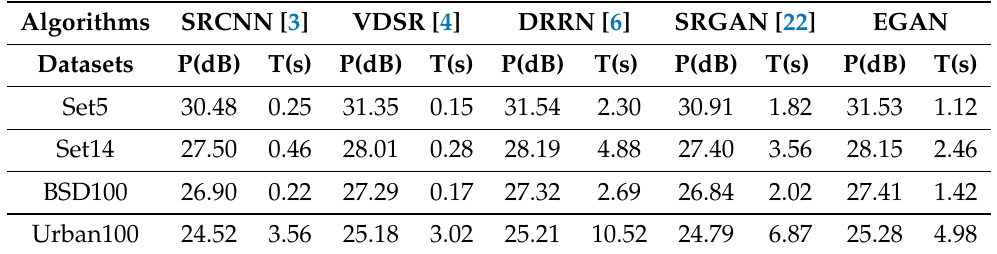
Table 3. The average PSNR (dB) and SR time (s) for a magnification factor of ×4 is compared. Algorithms